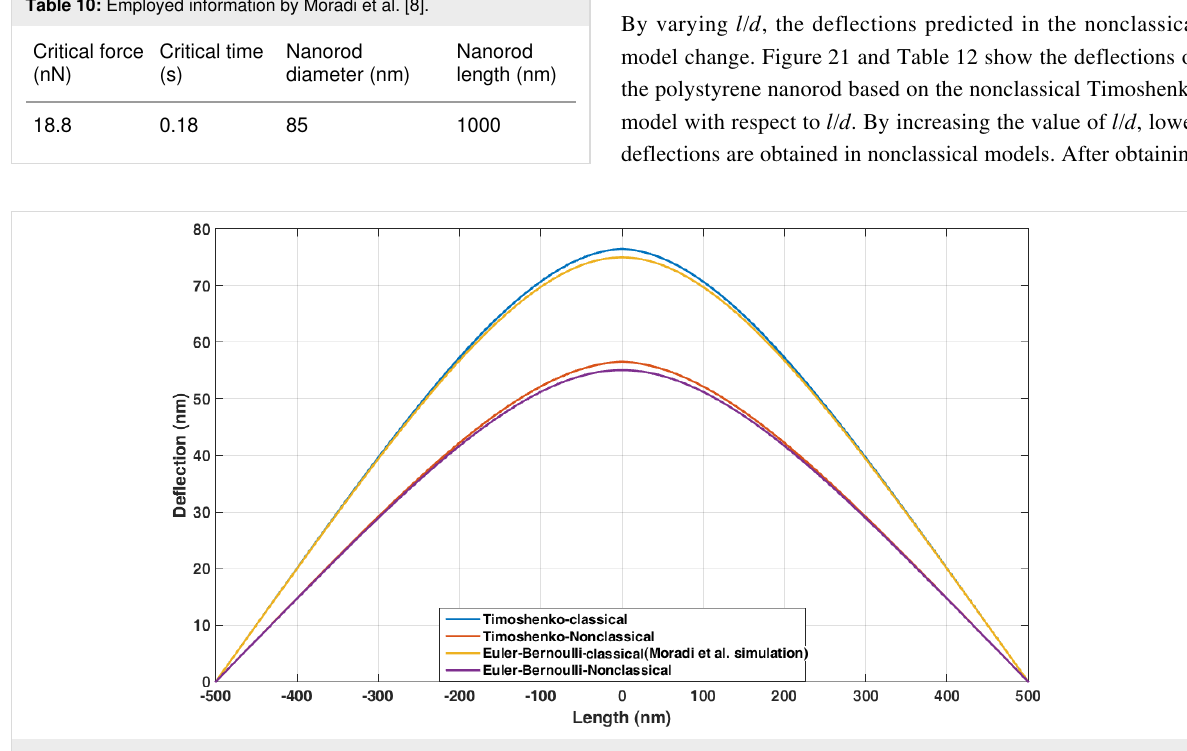
Figure 20: Comparison of the deflections of a polystyrene nanorod using classical and nonclassical models assuming l / d = 0.25.